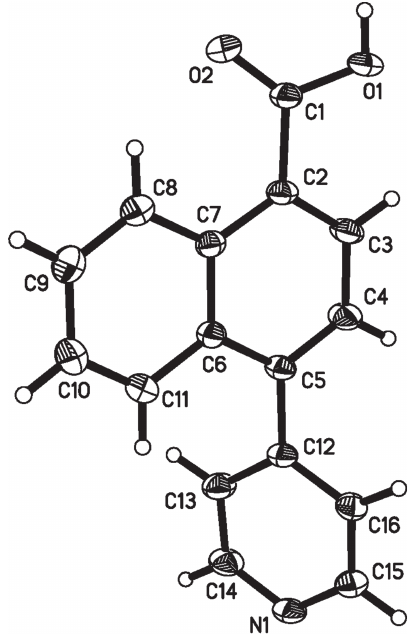
Table 1: Data collection and handling.